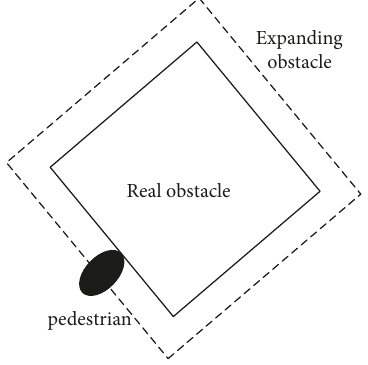
Figure 2: Obstacle expanding